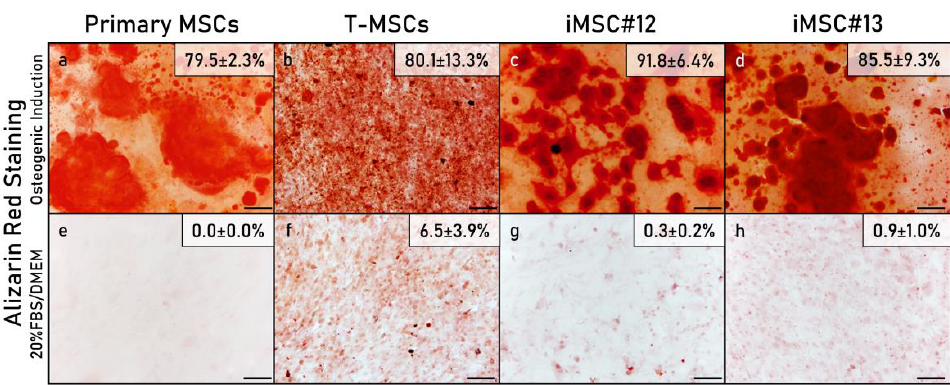
Figure 4. Mineralization analysis by means of Alizarin Red staining of primary MSCs, T-MSCs and iMSCs #12 and #13 after 3 weeks cultured in osteogenic medium ( a – d ) or grown in control medium (20%FBS/DMEM) ( e – h ). For each sample, the average percentage of the area stained by Alizarin Red is indicated. Information from primary parental MSC#13 and T-MSC#13 was not acquired because of cell number restrictions, and therefore only primary MSC#12 and T-MSC#12 are shown. Scale bar: 100 µm.